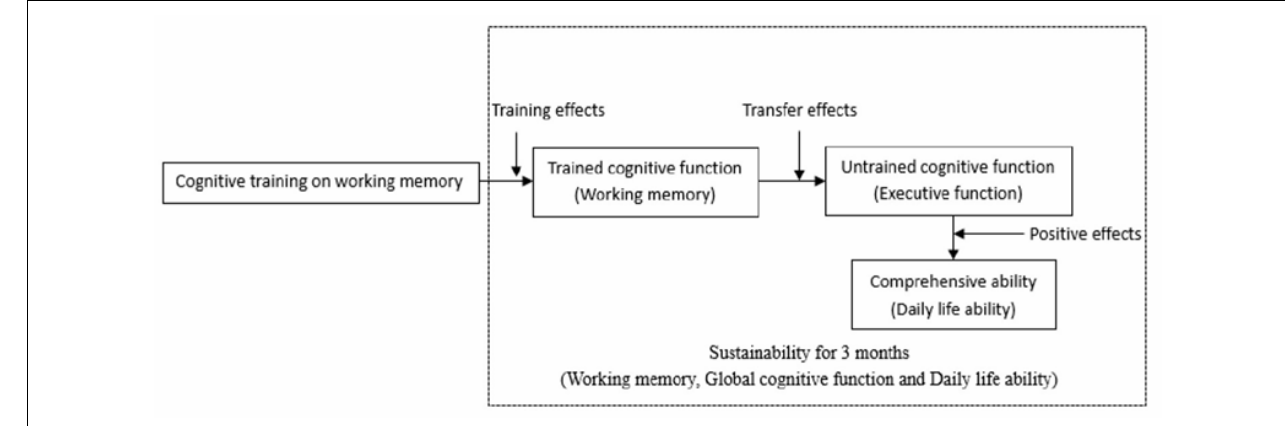
FIGURE 4 | Possible mechanism of cognitive